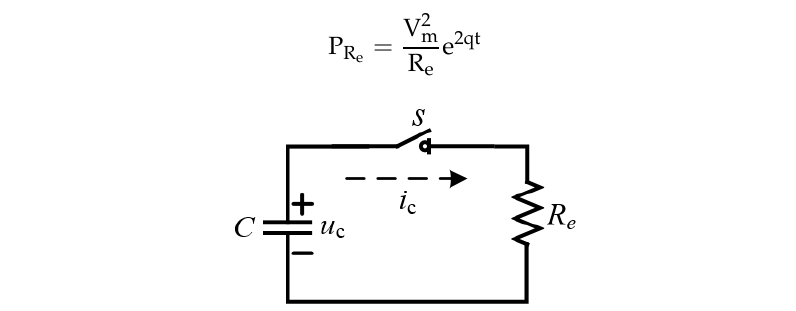
Figure 8. Relationship between capacitance C and key variables: (a) the relationship between V m and